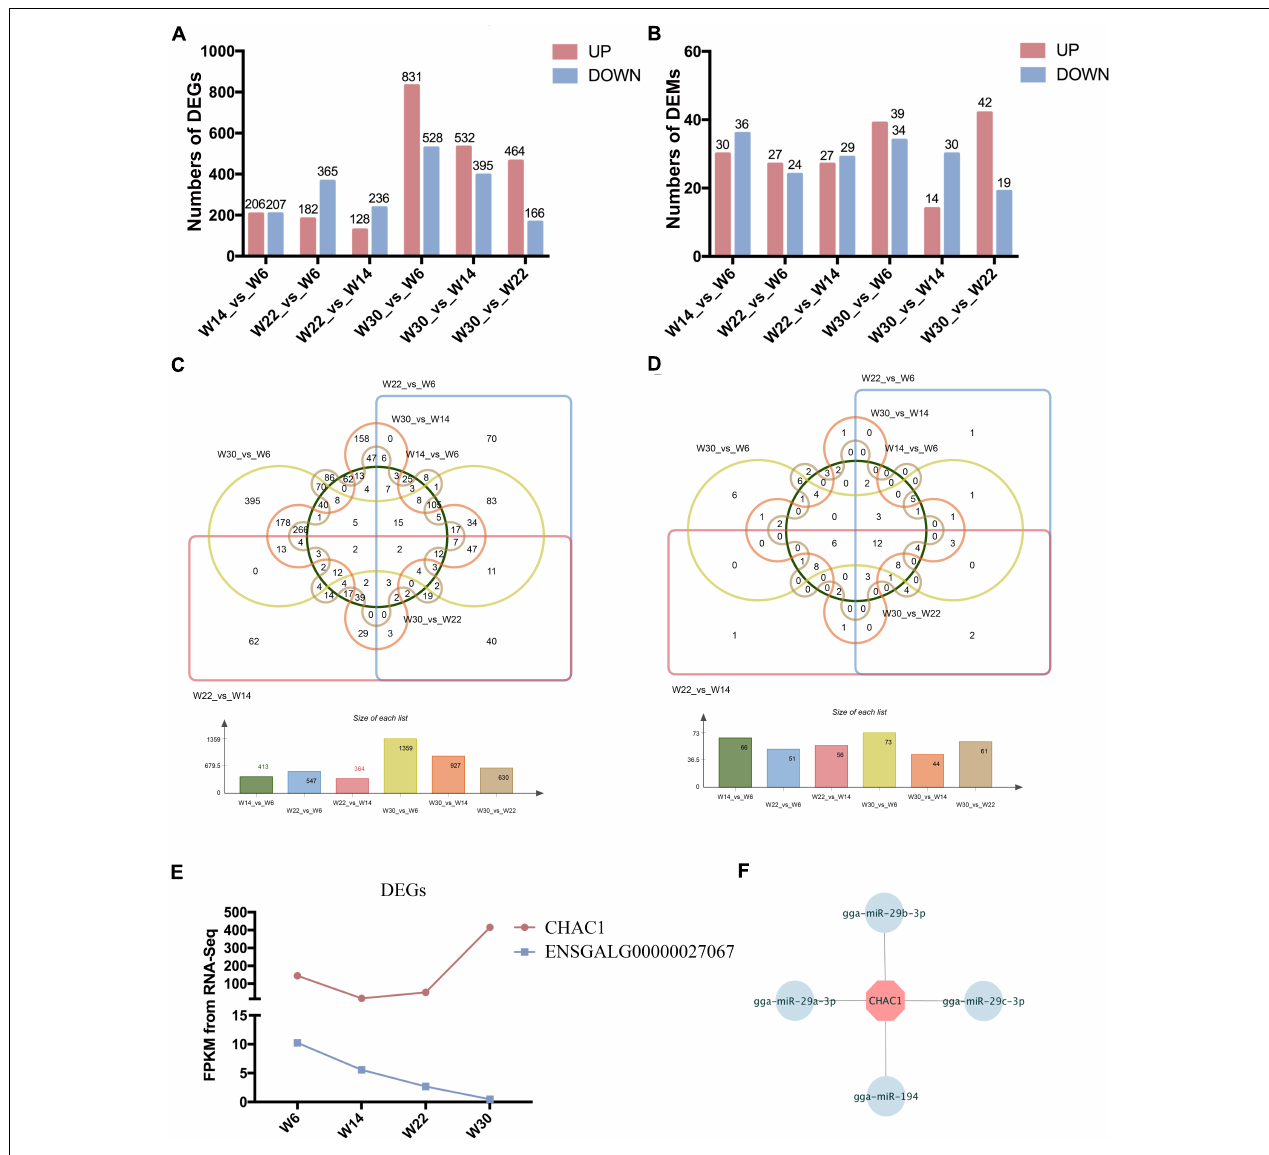
FIGURE 1 | The differentially expressed genes (DEGs) and miRNAs (DEMs) in chicken breast muscle. (A) The numbers of DEGs in different comparisons. (B) The numbers of DEMs in different comparisons. (C) The Wayne diagram of DEGs among the six comparisons. (D) The Wayne diagram of DEMs among the six comparisons. (E) The FPKM value of two DEGs ( CHAC1 and ENSGALG00000027067) in four developmental stages of chicken breast muscle. (F) The miRNA–mRNA pairs of CHAC1